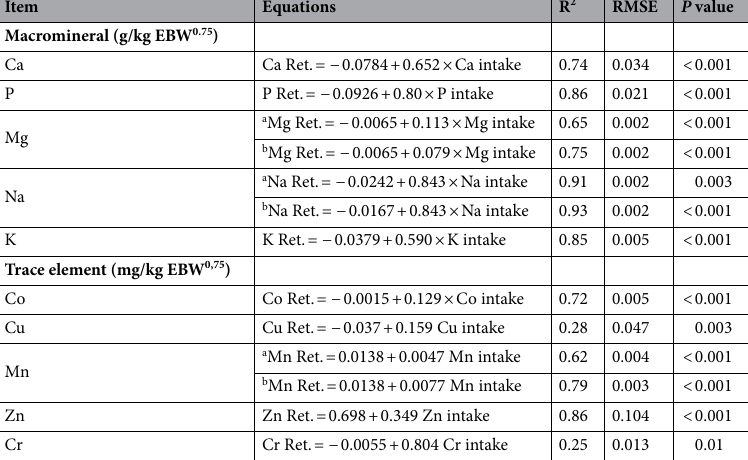
Table 7. Regression equations of the minerals retained from mineral intake to estimate the net maintenance requirements for macrominerals and trace elements of intact and castrated male Santa Ines hair sheep. Ret retained. a Intact male; b castrated